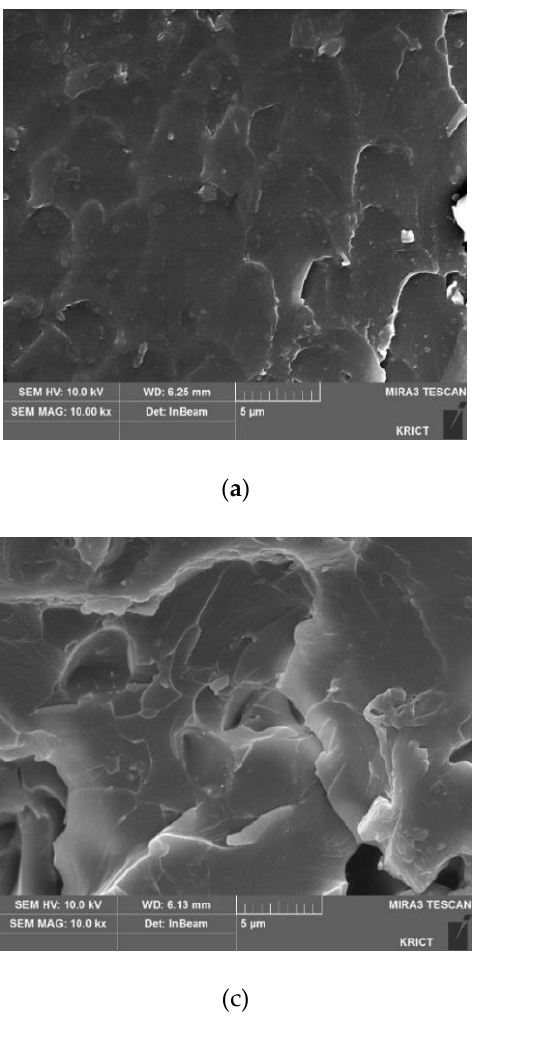
Figure 11. FE-SEM images of the fractured surface after impact testing with different BTCP contents: ( a ) 0 phr, ( b ) 5 phr, ( c ) 10 phr and ( d ) 20 phr.